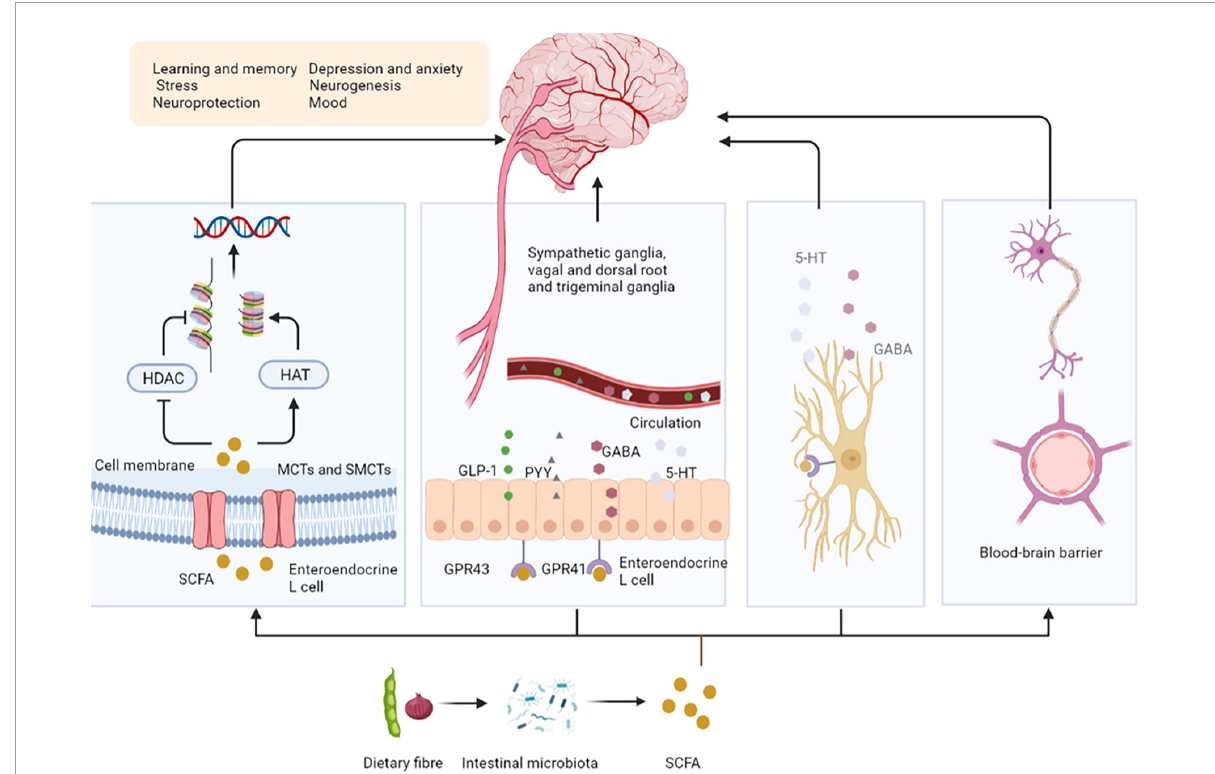
FIGURE1 Short-chain fatty acids affect central nervous system activity. SCFAs are absorbed by colonocytes mainly through MCT or SMCTs. By inhibiting the activity of HDACs or increasing the activity of HATs, acetylation can be stimulated to produce chromatin with transcriptional activity and promote gene transcription. SCFAs bind to GPR43, GPR41 on enteroendocrine cells to stimulate their L cells to secrete GLP-1, PYY, GABA, and 5-HT, send signals to the brain. SCFAs can upregulate the expression of tight junction proteins, regulating the growth and development of neurons and synapses. Finally, in the CNS, SCFAs affect the morphology and function of microglia to influence neuro inflammation. SCFAs, short-chain fatty acids; MCTs, H + –dependent monocarboxylate transporters; SMCTs, Na + -dependent monocarboxylate transporters; HDACs, histone deacetylases; HATs, histone acetyltransferases; GPR43, free fatty acid receptor 2, GPR41, free fatty acid receptor 3; GLP-1, glucagon-like peptide 1; PYY, peptide YY; GABA, gamma-aminobutyric acid; 5-HT, 5-hydroxytryptamine; BBB, blood-brain